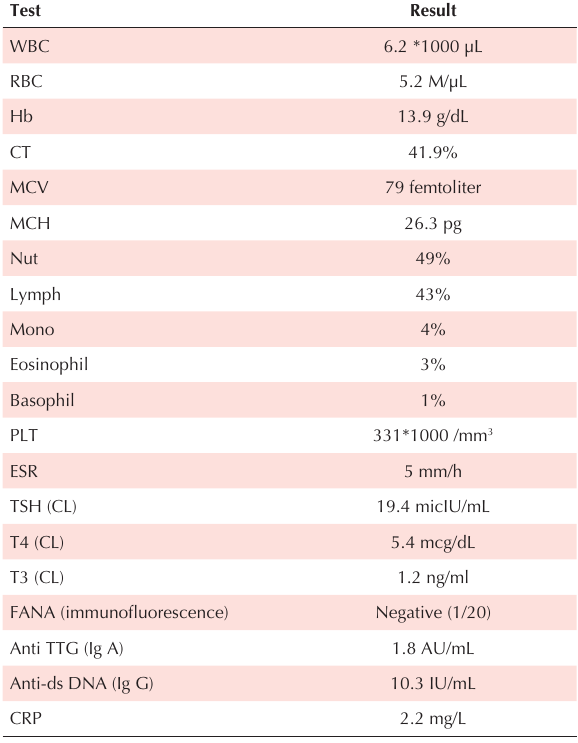
Figure 4. Brain MRI shows fluid surrounding bilateral optic nerves. Table 1. The biochemical test before treatment with levothyroxine Test